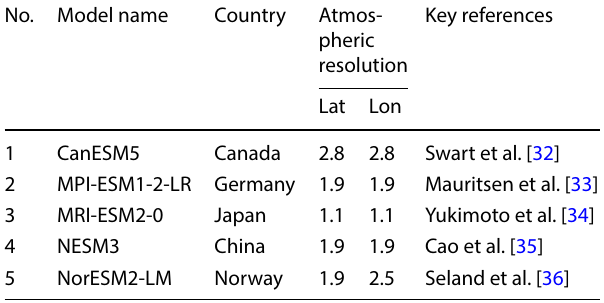
Table 2 List of selected GCMs under CMIP6 No. Model